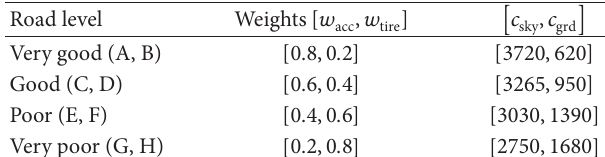
Table 2: Parameters of quarter vehicle. Table3:Controlweightsanddampingcoefficientsfordifferentroad levels.